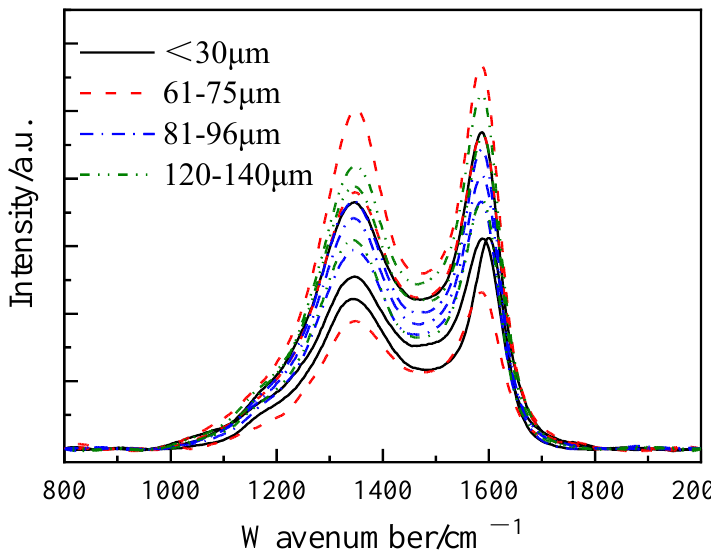
Figure 5. Raman peak spectrum intensity of char1 for different particle sizes.